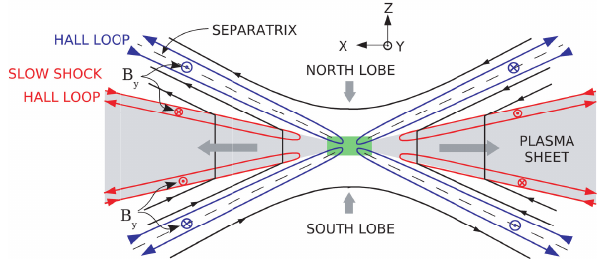
Fig. 36. Schematic drawing of Hall-current driven loops in the re- gion surrounding a reconnection site (separatrix loops in blue; slow shock loops in red). Green box in the center is the ion “diffusion”